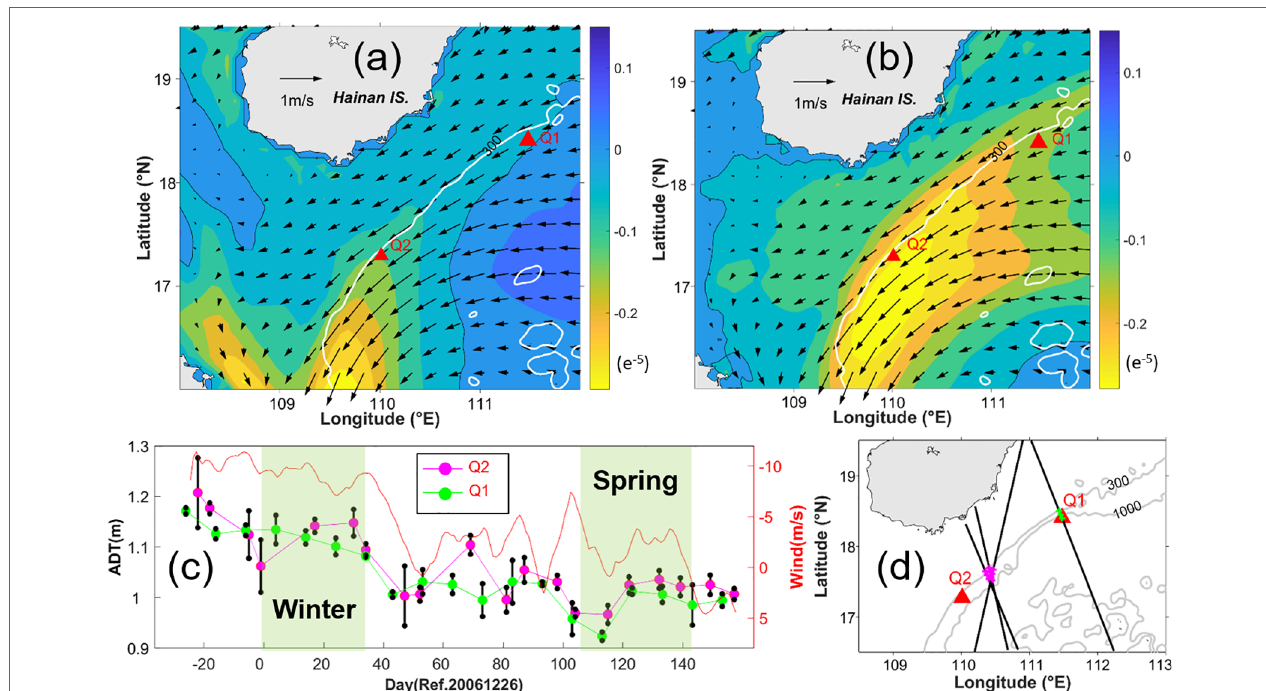
FIGURE 10 | The along-slope (A) and cross-slope (B) of mean sea level gradient (the positive values correspond to the northeast and off-shore directions, respectively); the mean surface velocity field was overlayed around northwestern SCS, derived from the HYCOM output during the mooring period in deep winter of 2006-2007. The mean ADT (C) near the stations Q1 (green dotted line) and Q2 (magenta dotted line) derived from satellite along-track data (black lines) (D) , to show the variation of sea level along the slope region; the error bars correspond to standard deviation of the ADT; the blue shading in (C) highlights the two mooring periods; and the along-shore component of the wind (red line) in the study region is